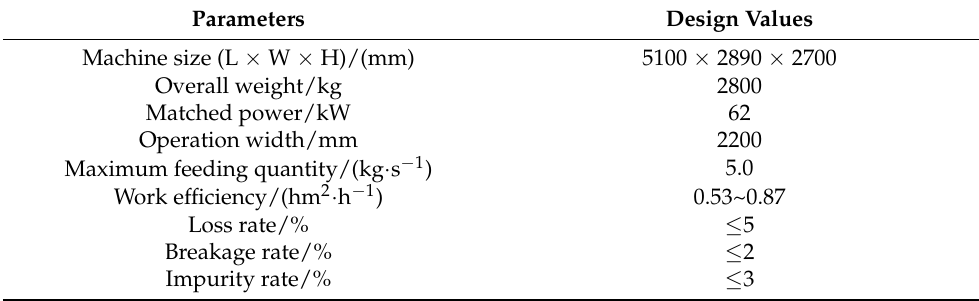
Table 1. Key technical parameters of the Chinese milk vetch seed combine